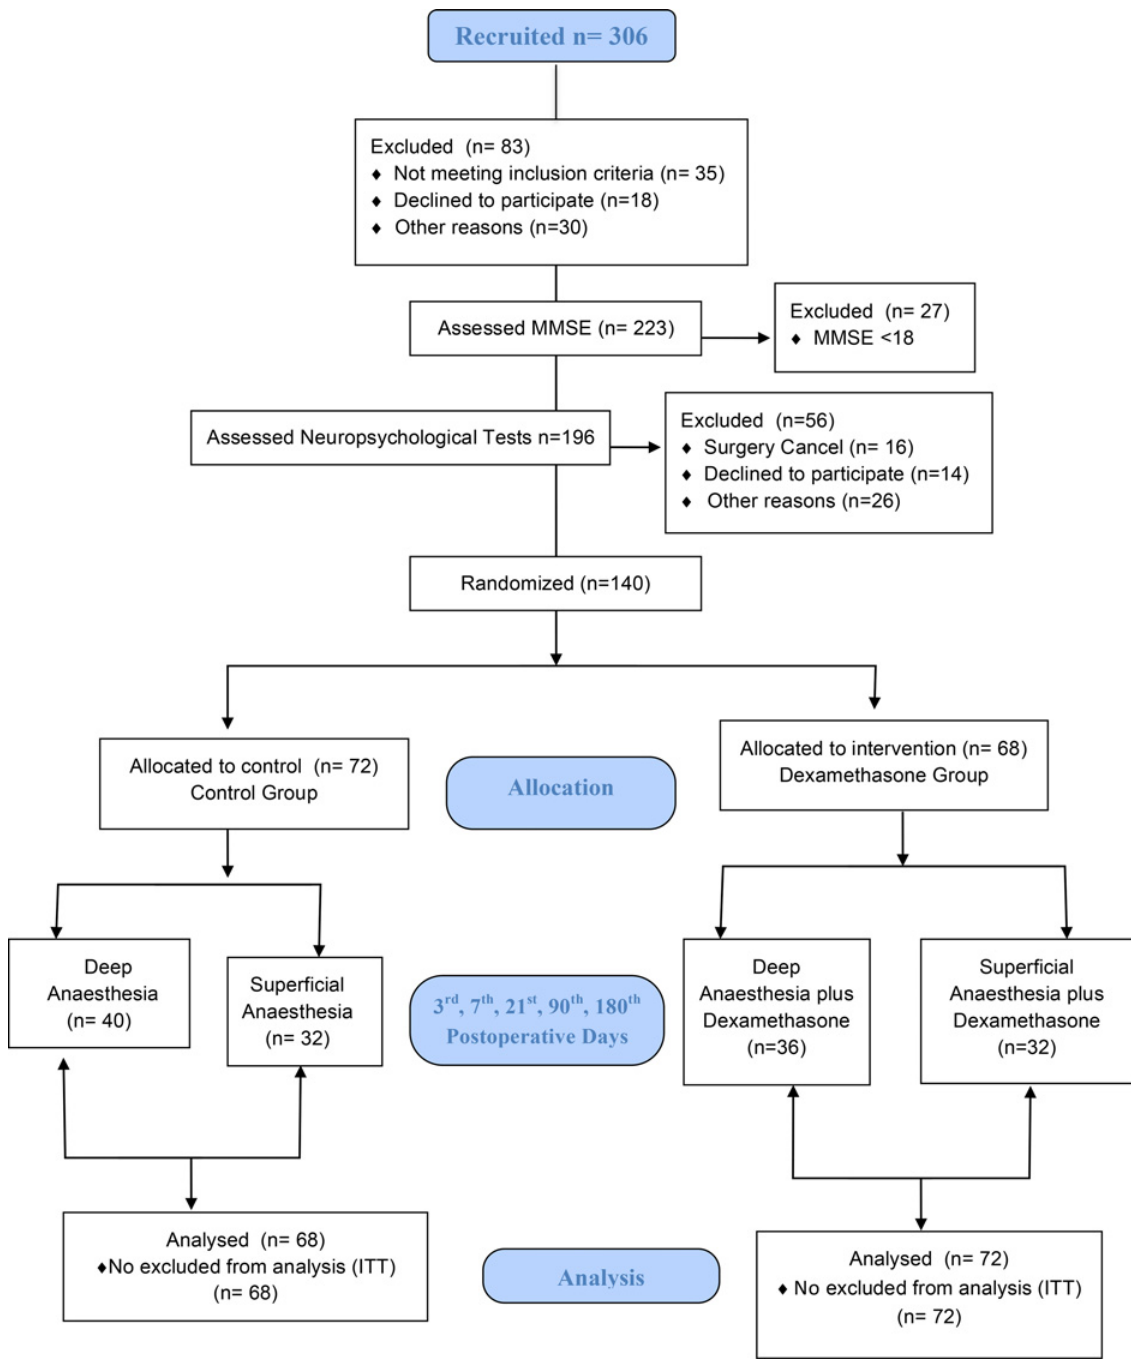
Fig 2. Study Fluxogram. MMSE: Mini-Mental State Examination; ITT: Intention to treat.